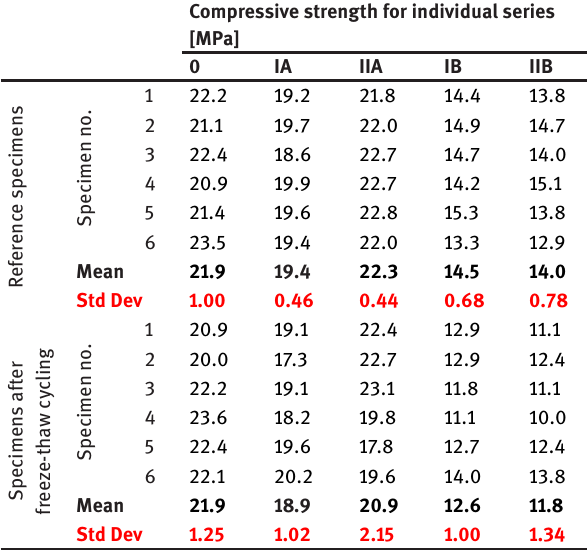
Table 5: Compressive strength values.